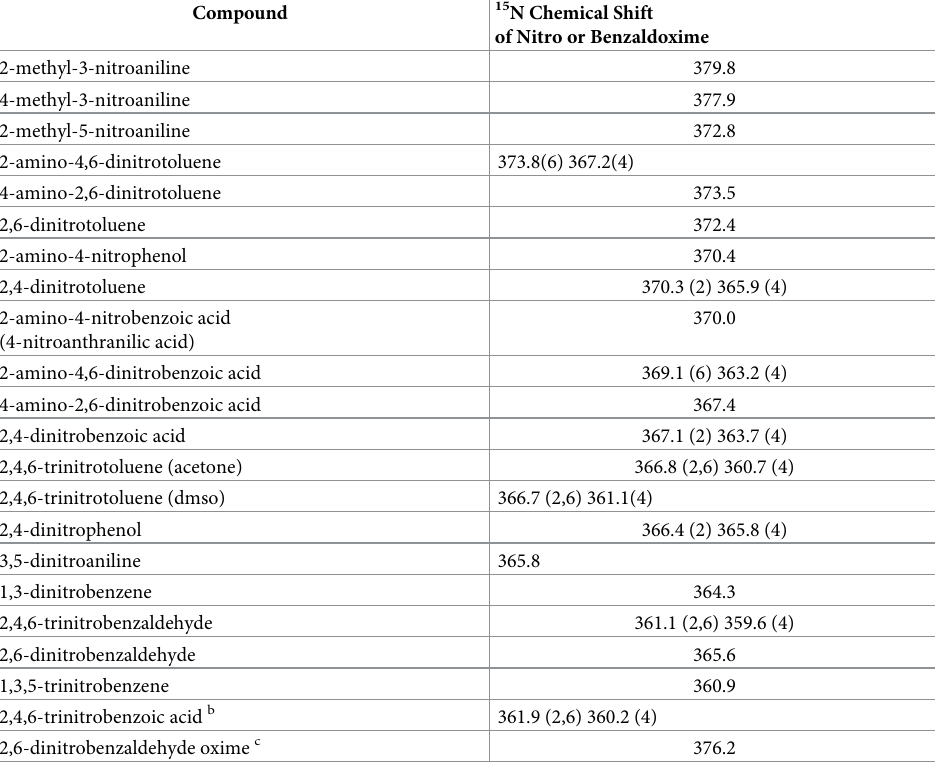
Table 5. Liquid State N-15 NMR chemical shifts of nitro and benzaldoxime nitrogens a